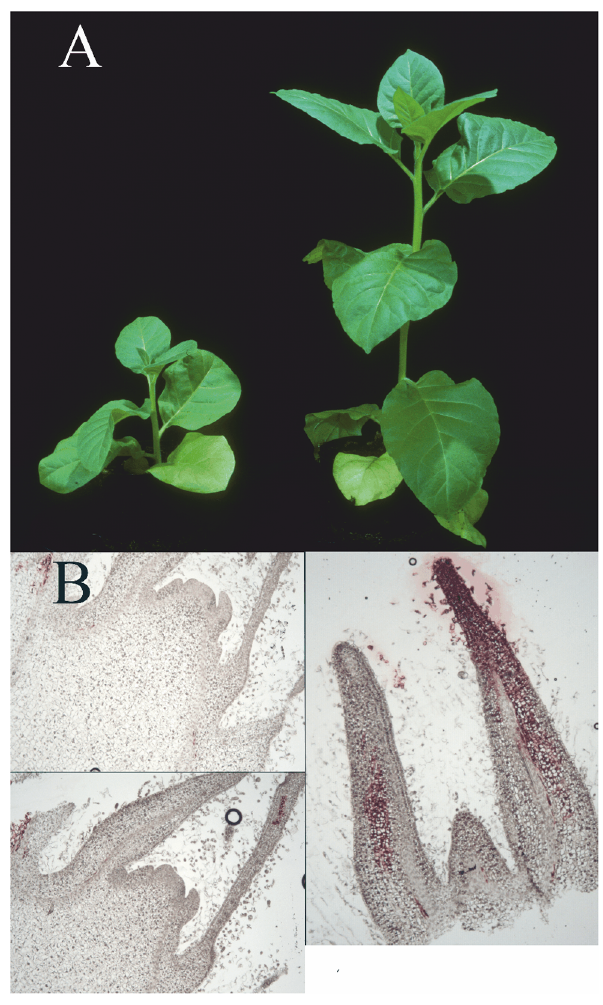
Figure 1. Phenotype of the transgenic plants that harbor the full length infectious TMV cDNA, under 35S promoter. (A) BRB- TMV transgenic plant (on the left), at the age of six weeks after germination. The plants show no viral symptoms, and do not contain any detectable viral RNA or CP, but they are severely stunted as compared to the wild type plants of the same age. (B), Anti-TMV CP labeled thin sections of the apical domain of the TMV transgenic plant during the early stage of the resistance break (at 8 weeks after germination). Isolated TMV-positive foci are detected in the vascular tissue, and in the tips of leaf initials. On the left, two adjacent sections are shown to illustrate the small size of the foci.